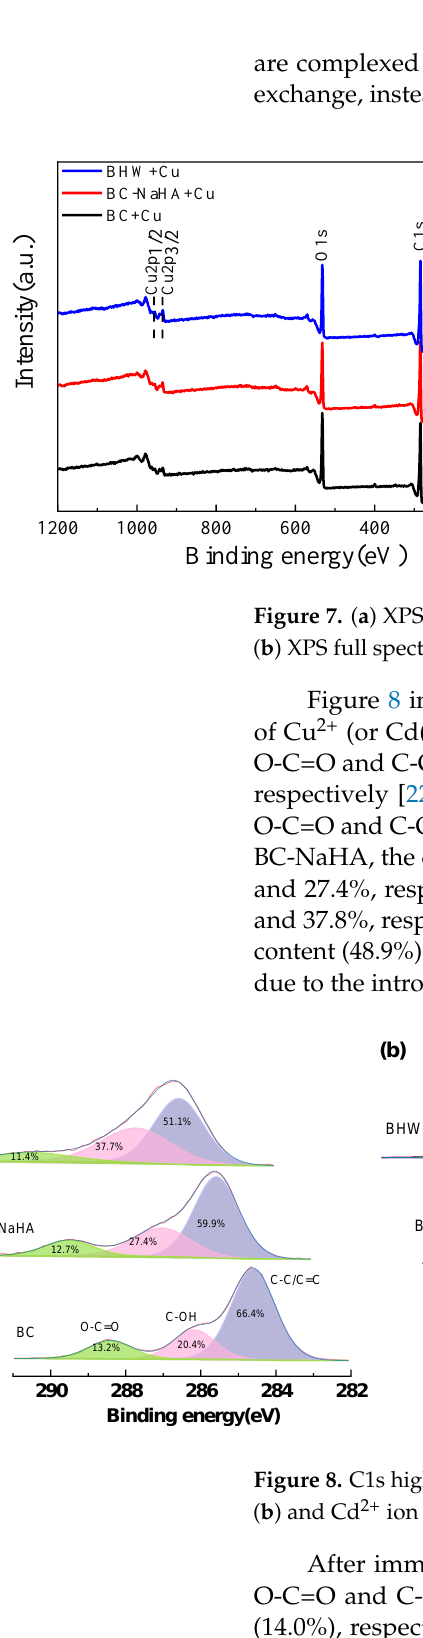
and Ca2P on BHW and BC-NaHA materials, but the peaks of Na1S and Ca2P disappear after Cd 2+ and Cu 2+ ions are absorbed. The main reason is that Cd 2+ and Cu 2+ ions are complexed with BC-NaHA and BHW oxygen-containing functional groups by ion- exchange, instead of Na( ⅰ ) ions and Ca 2+ ions [12].